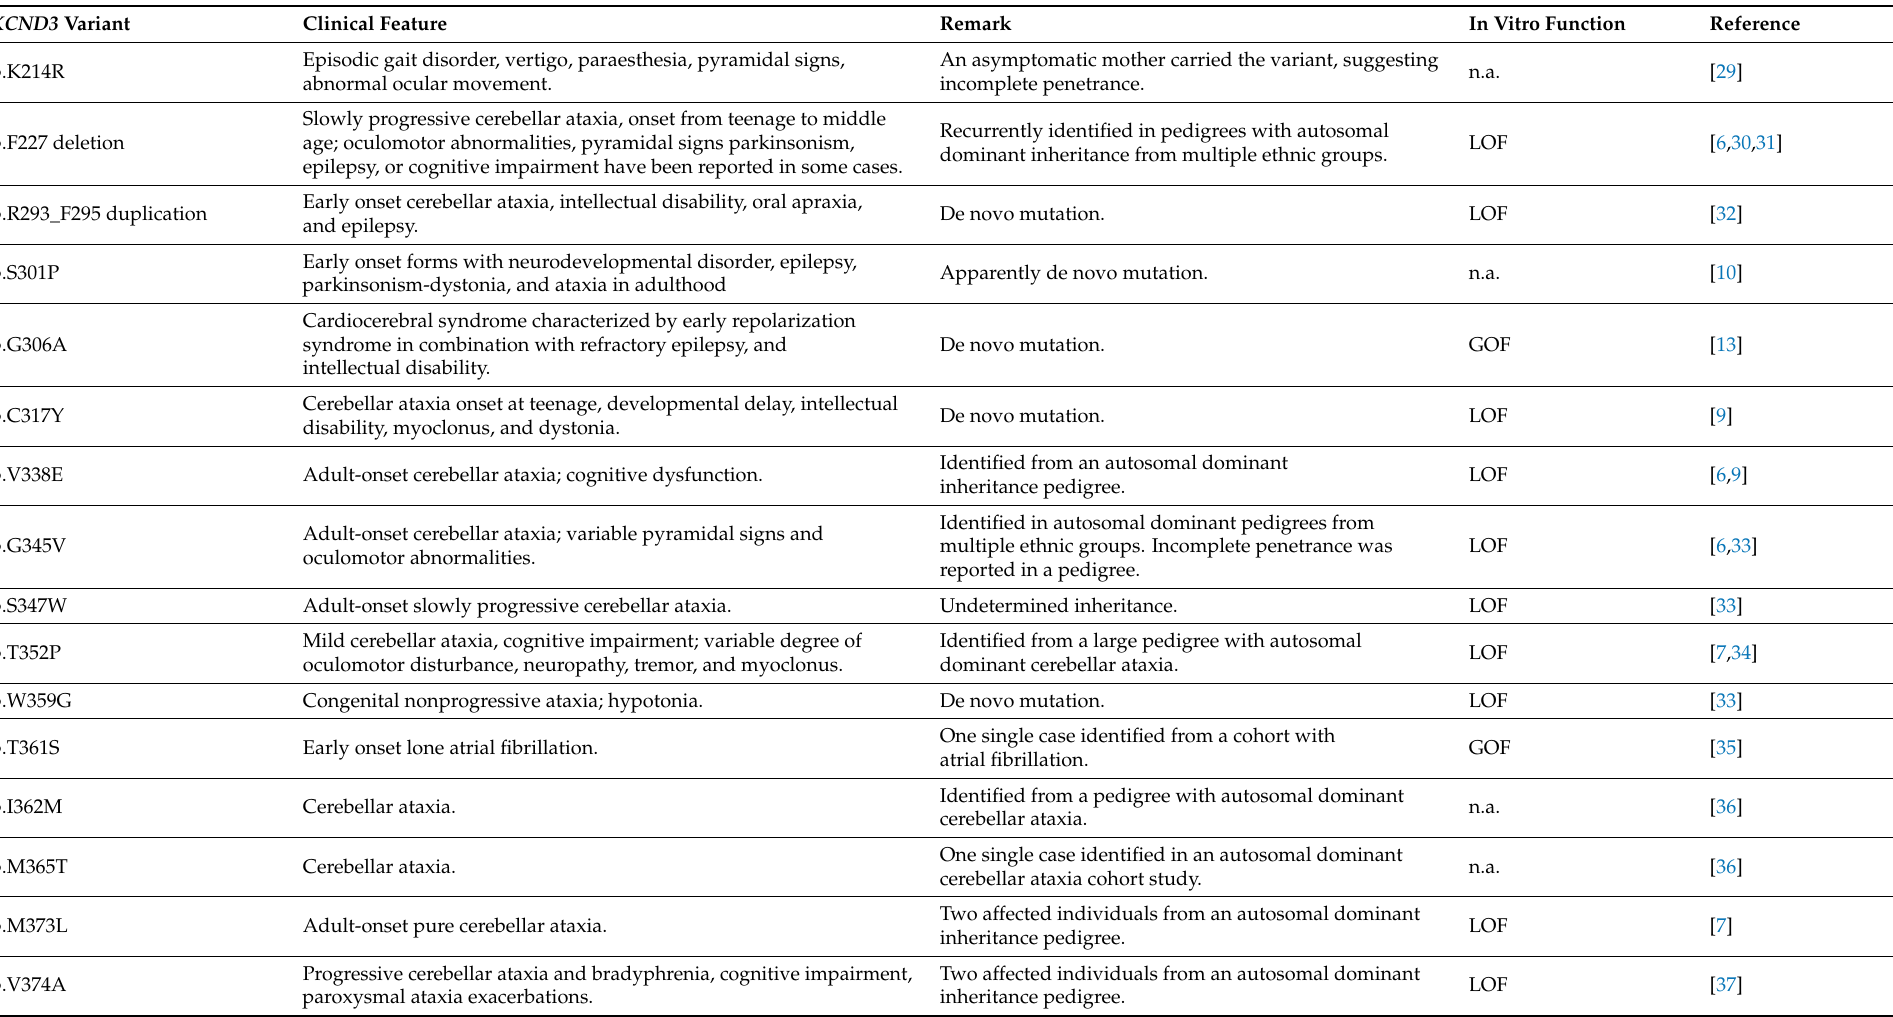
Table 3. The genotype–phenotype relationship for KCND3 variants associated with neurological or cardiac disorders. Notation for in vitro functional phenotype: GOF, gain of function; LOF, loss of function; NSFC, no significant function change; n.a., not available. See Figure 5 for topographic